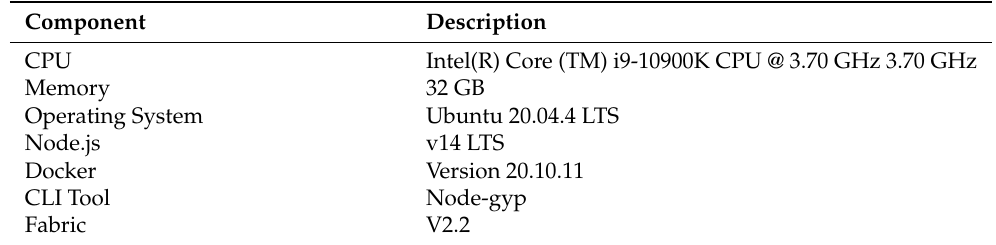
Table 4. Simulation and Hyperledger Caliper environment